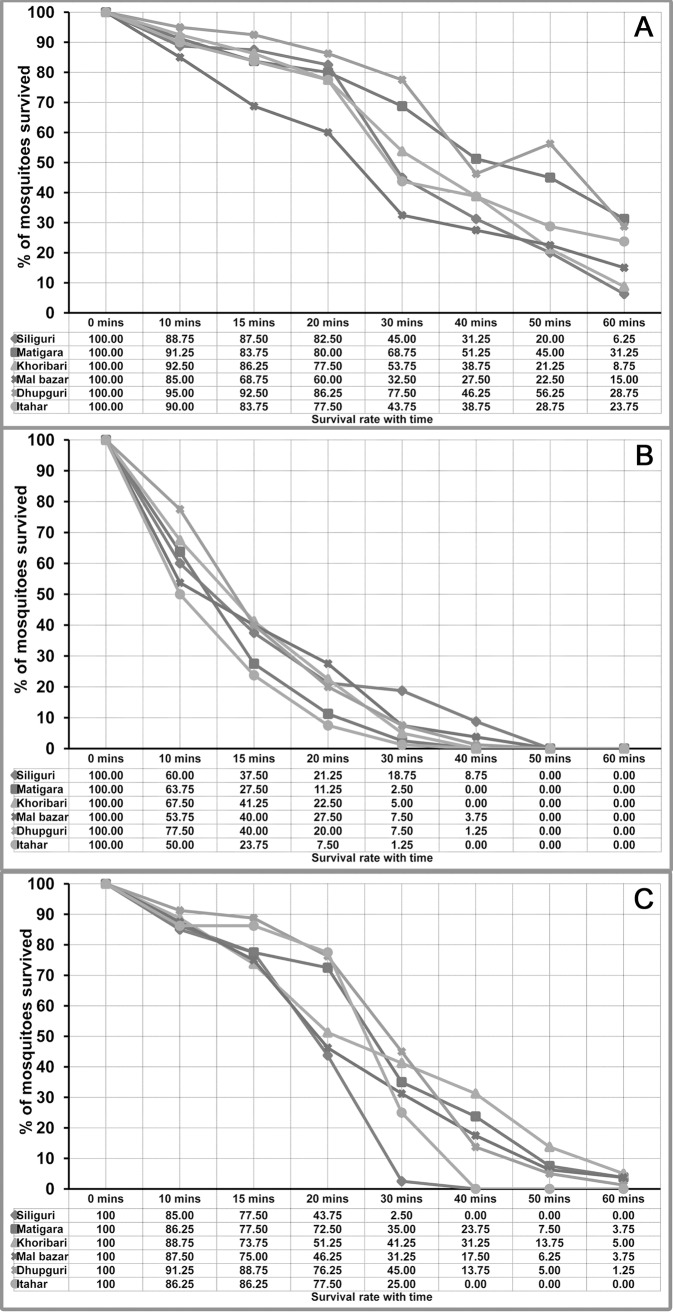
Survival rate of Aedes albopictus against 4% DDT (A), 0.05% deltamethrin (B), 5% malathion (C) in West Bengal.